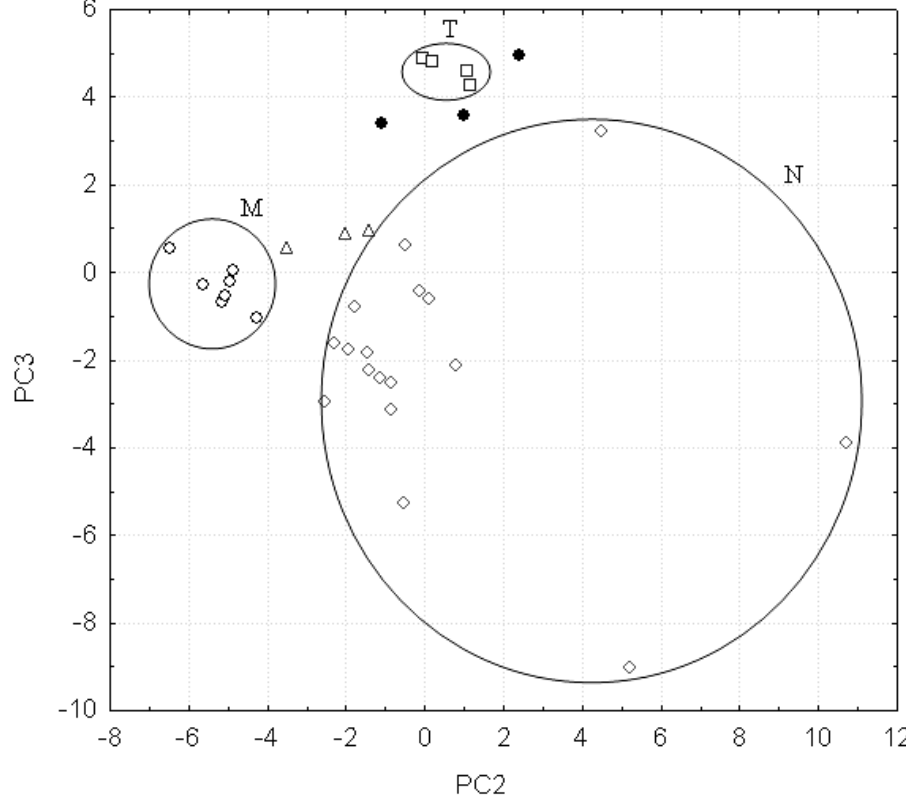
Figure 4. Score plot for the training set (series ○ for stimulant amphetamines, series □ for hallucinogenic amphetamines and series ◊ for nonamphetamines), and for the false M positives (series ∆ ) and false T positives (series ● ).